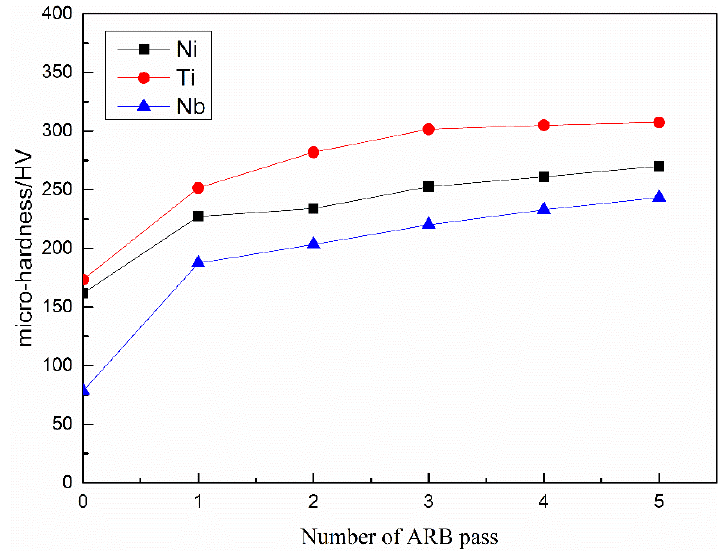
Figure 7. Variations of micro-hardness versus the number of the ARB pass.